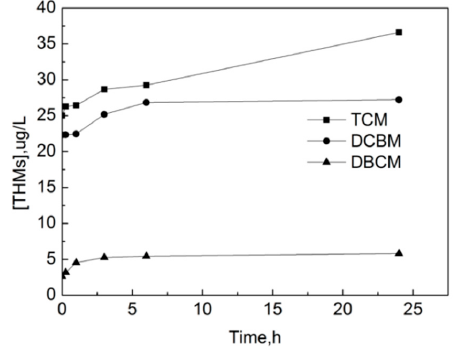
Figure 15. The formation curve of trihalomethanes (THMs) in the process of OOFC.